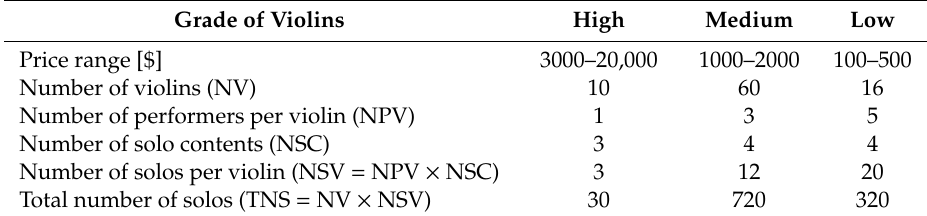
Table 1. Details of the violin